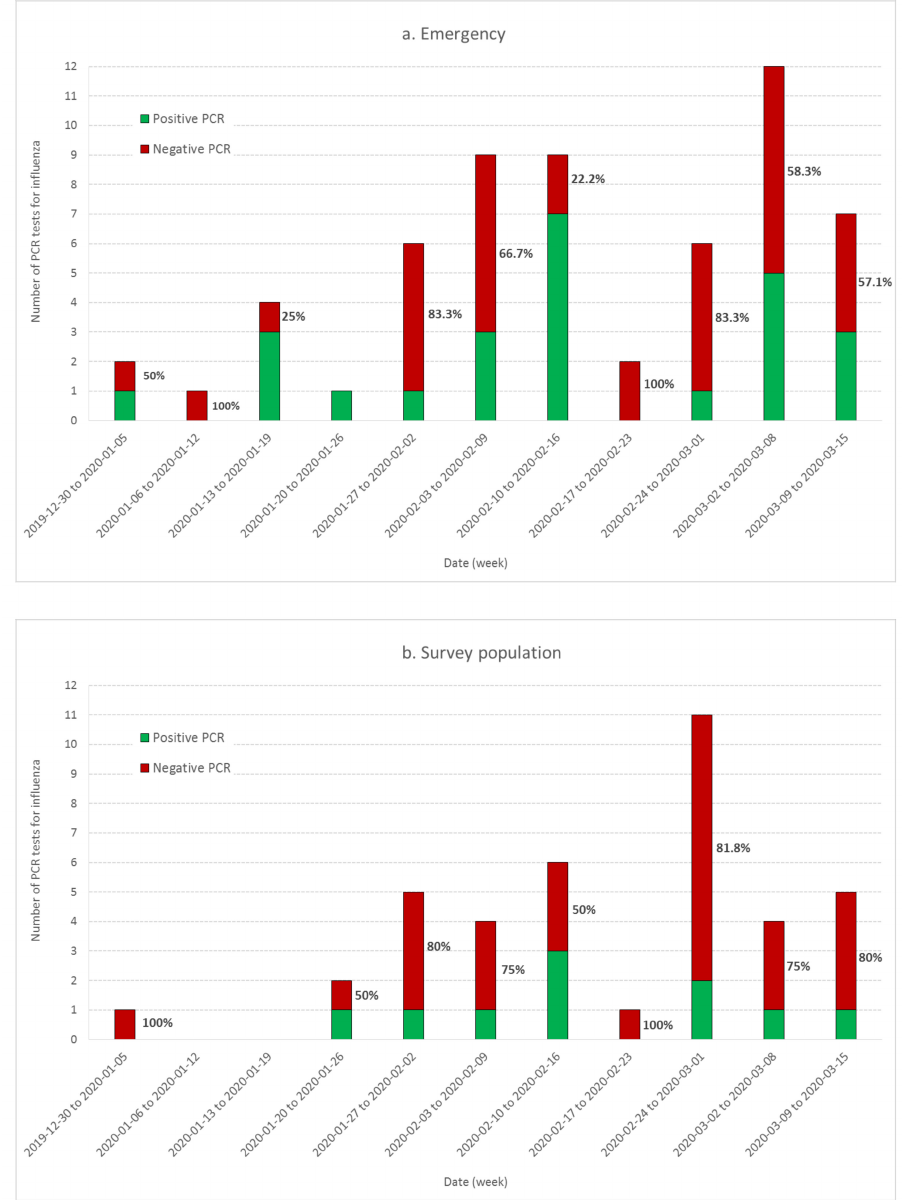
Figure 3. Time evolution of the proportion of influenza PCR positive (green) and negative (red) tests conducted at the Diaconat-Fonderie biology laboratory ( a ) and documented in the population-based survey ( b ). The rate of negative tests as a function of time is documented on each